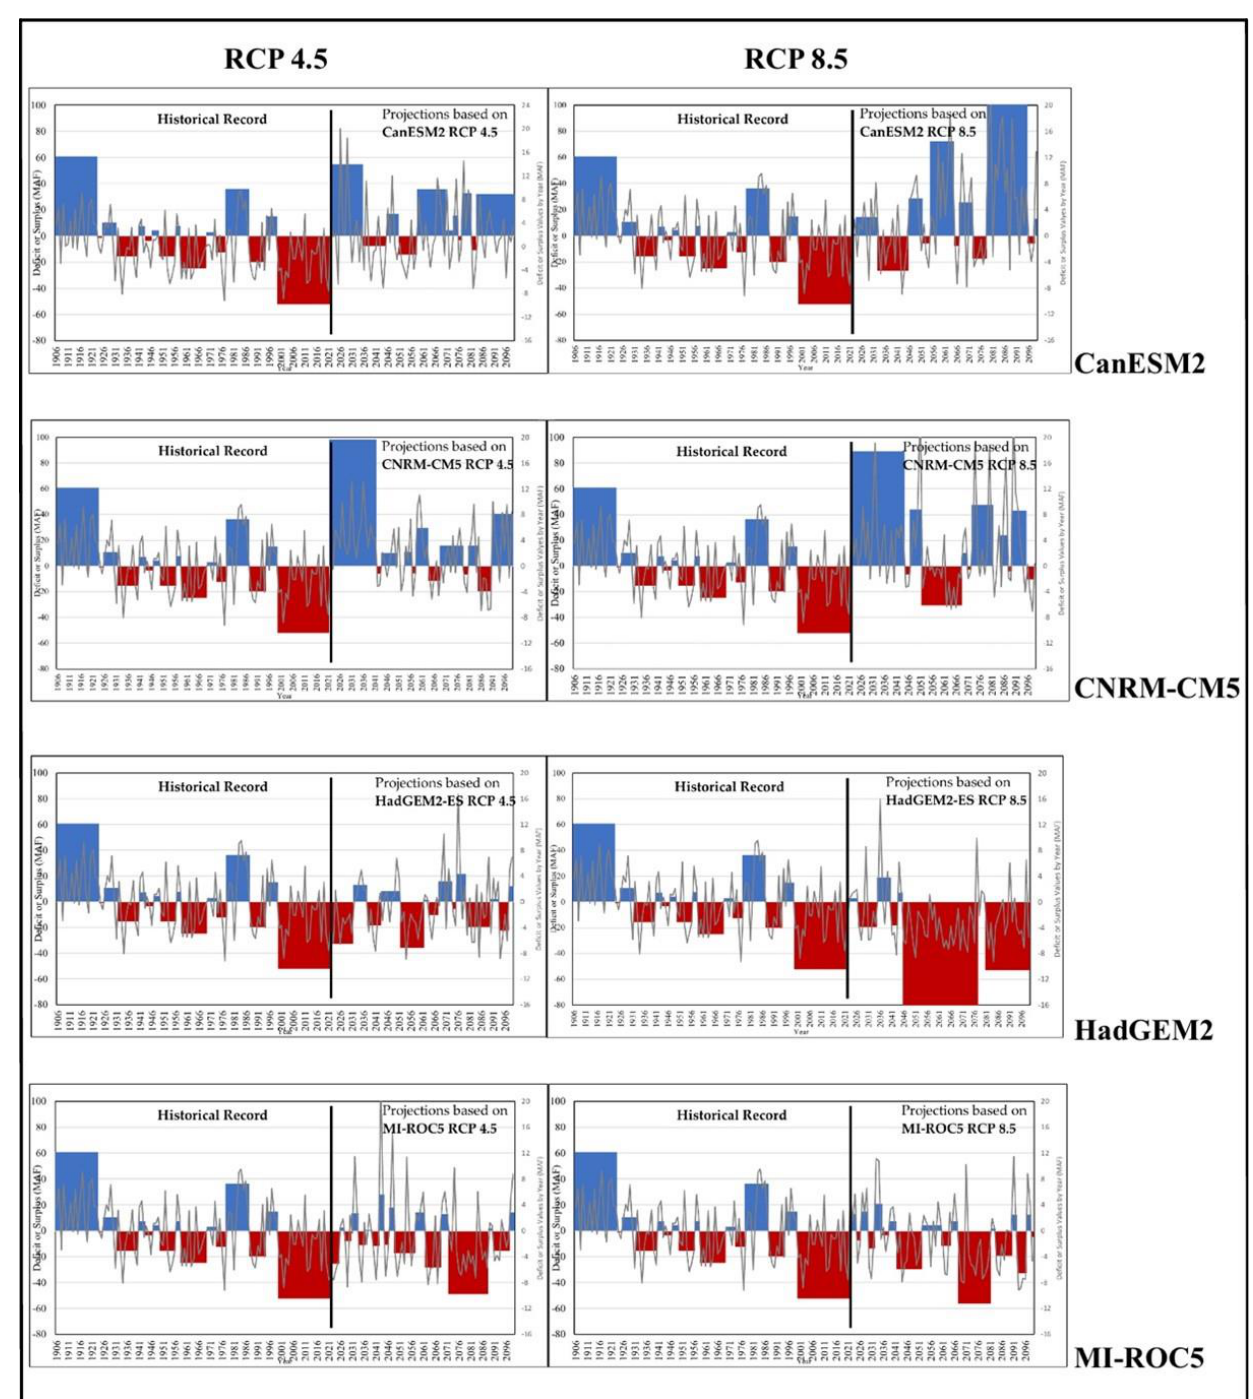
Figure 5. Time series of historical and future projections at Lees Ferry for all scenarios. Blue areas are surplus periods and red areas are deficit periods. (Note: 1 MAF = 1233 million cubic m).